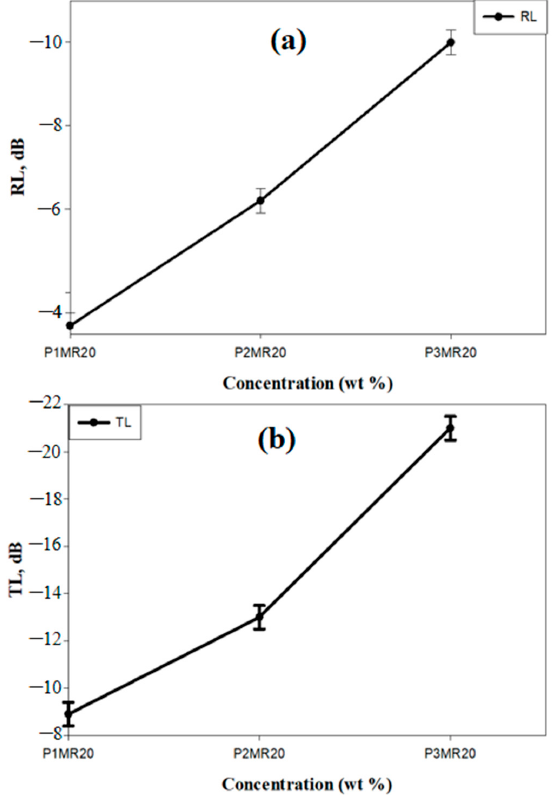
Figure 12. ( a ) Reflection loss, ( b ) Transmission loss, ( c ) Total shielding as a function of the frequency for P 1 MR20, P 2 MR20, and P 3 MR20. ( d ) The electrical conductivity results for the PU composite foams.